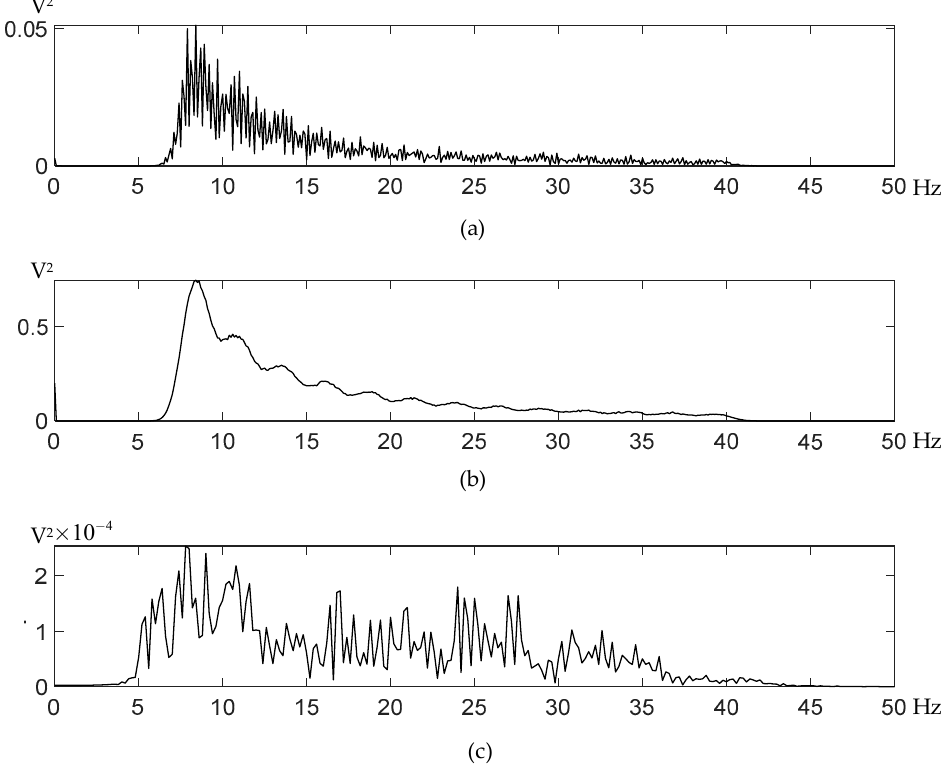
Figure 11. The averaged amplitude-frequency responses of EEG signals recorded from dolphin BL-8 when motionless ( a ) and during swimming ( b ) and dolphin BL-3 recorded ashore ( c ).